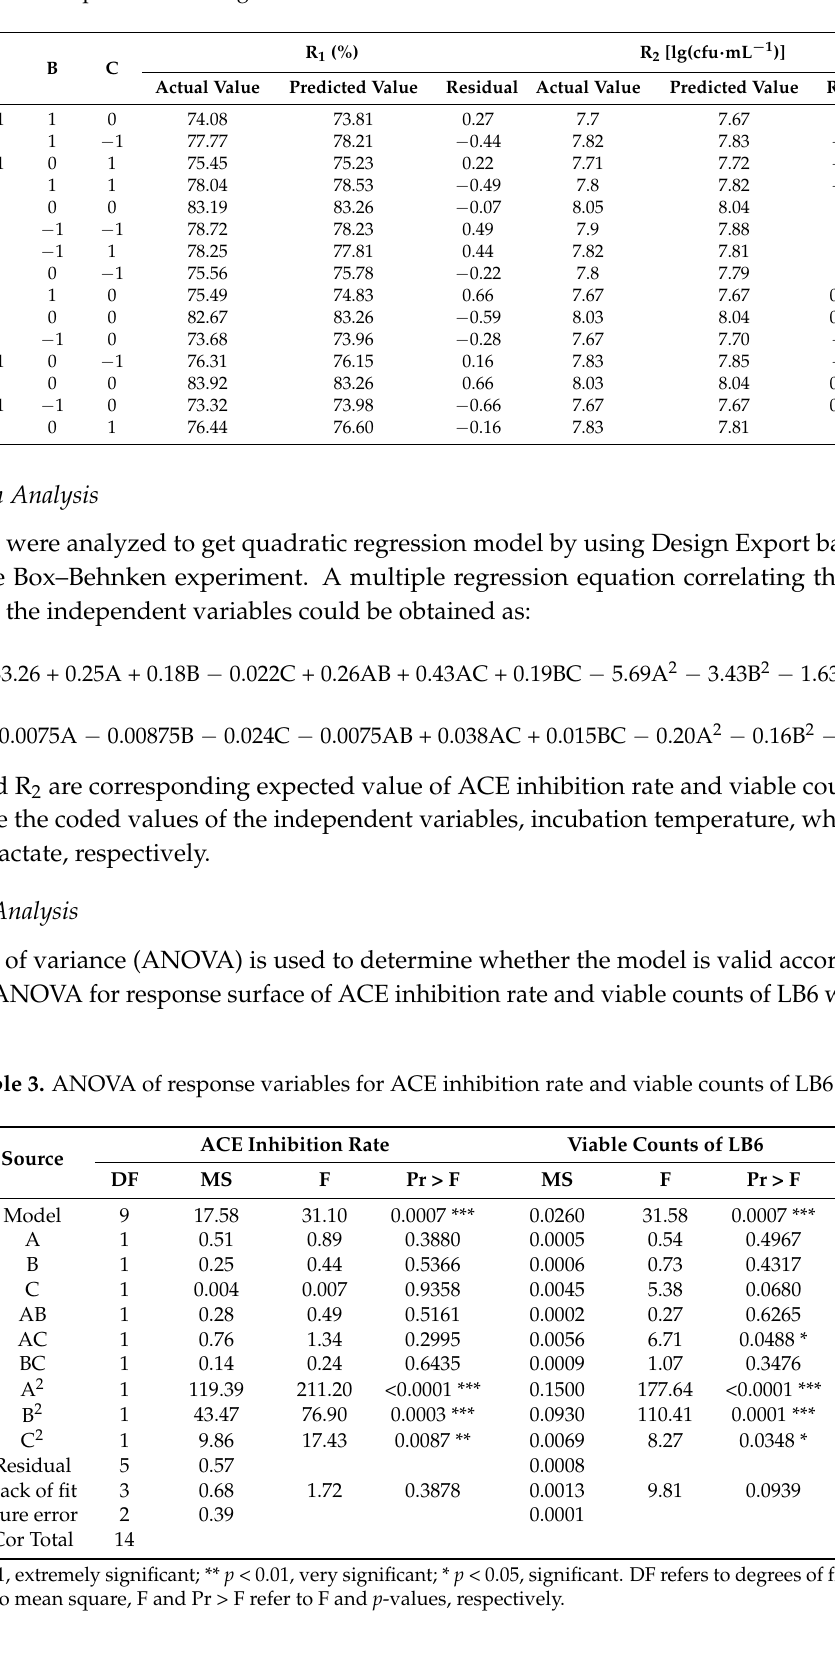
Table 2. The experimental design and results of Box–Behnken for incubation conditions of LB6.